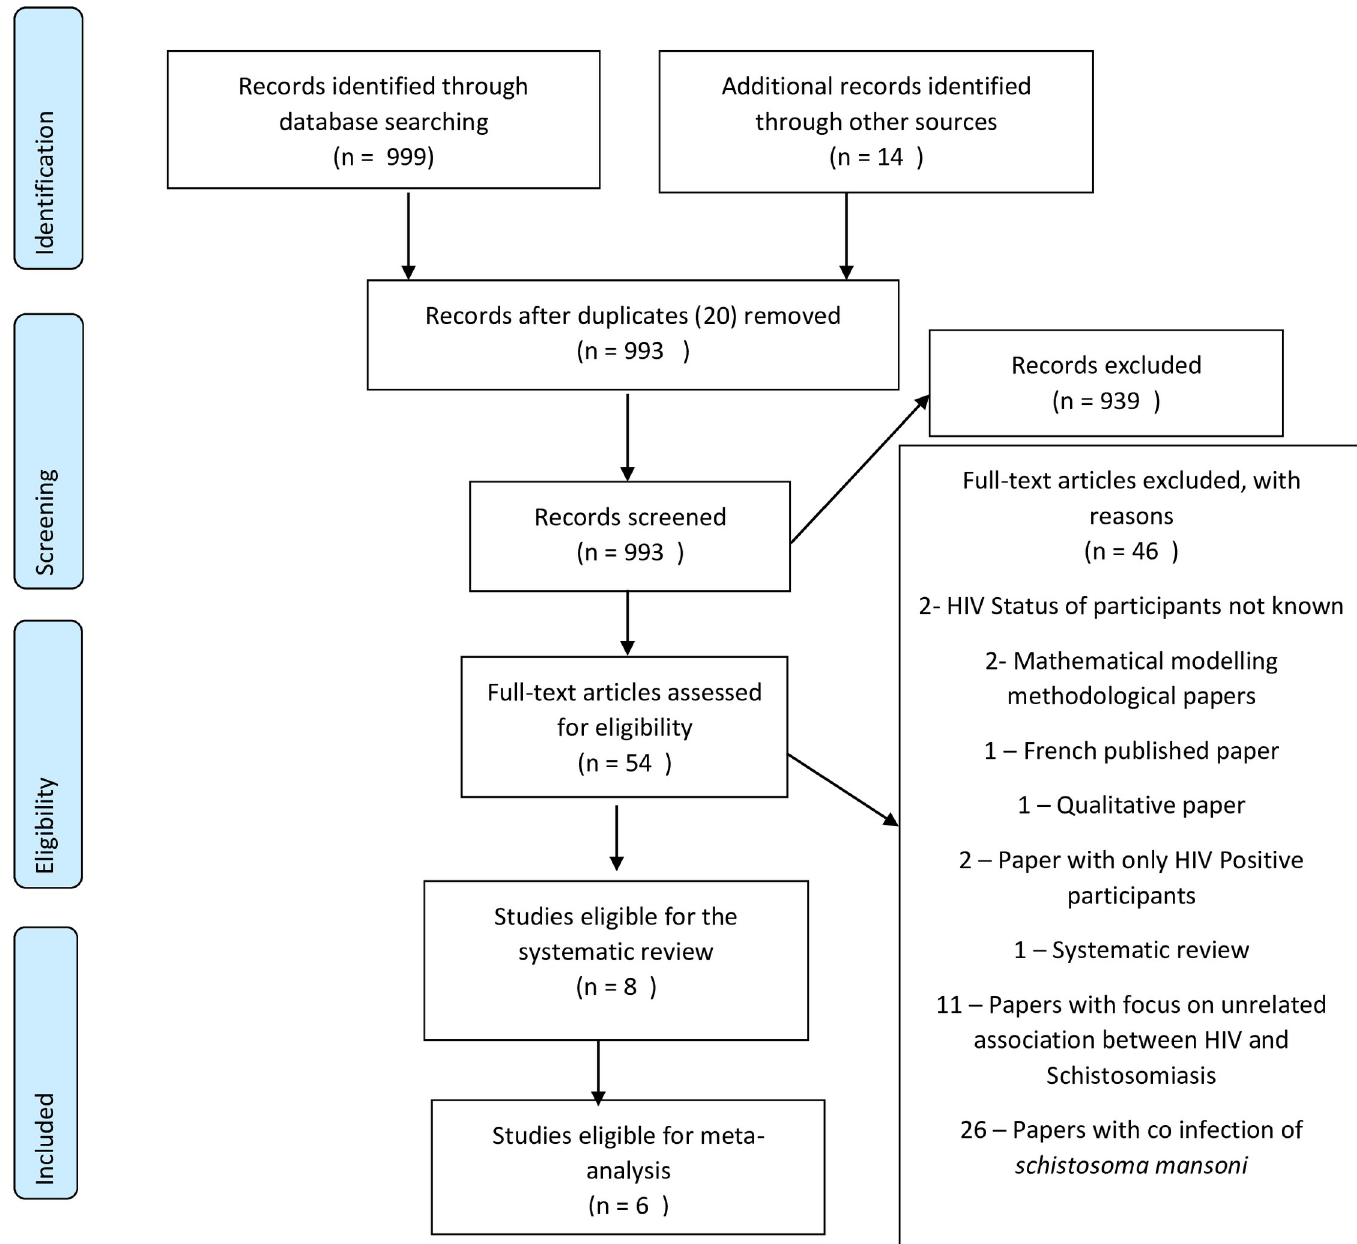
Fig 1. Flow diagram for search and selection of included